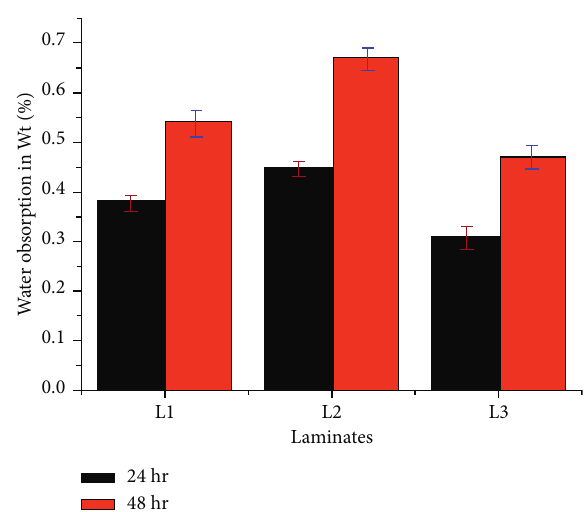
Figure 3: Representation of water absorption comparative